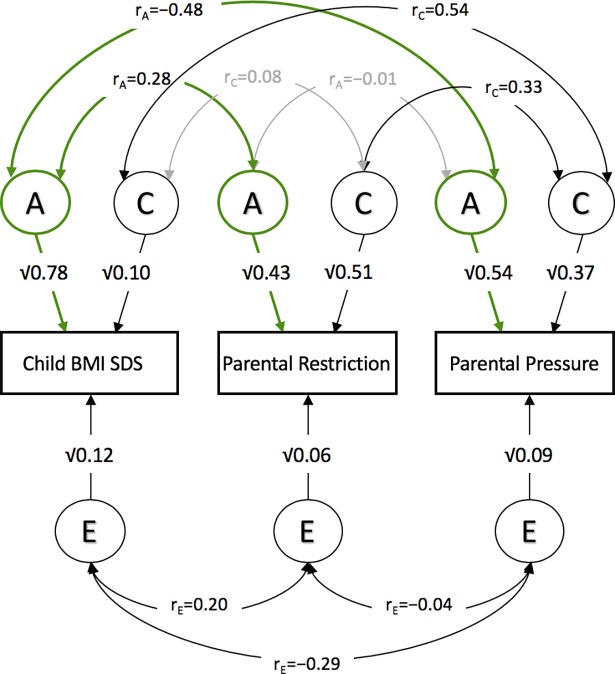
The correlated factors model.A correlated factors model (males and females combined) showing: (i) the genetic (A), shared environmental (C) and non-shared environmental (E) influences on child BMI SDS, parental restriction and pressure; and (ii) common genetic (rA), shared environmental (rC) and non-shared environmental (rE) correlations between child BMI, and parental restriction and pressure. Grey arrows indicate non-significant associations. Correlations including the 95% confidence intervals can be found in Supplementary S3 Table.